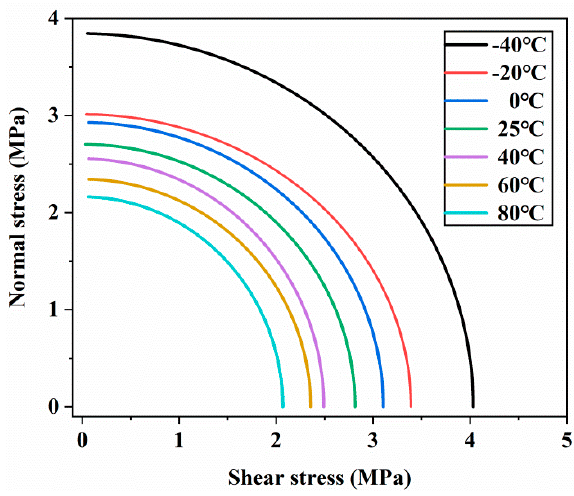
Figure 15. Failure criterion curves of adhesive joints at different temperatures. Table 12. Parameters of failure criteria and corresponding goodness of fit at seven temperatures. Temperature ( ◦